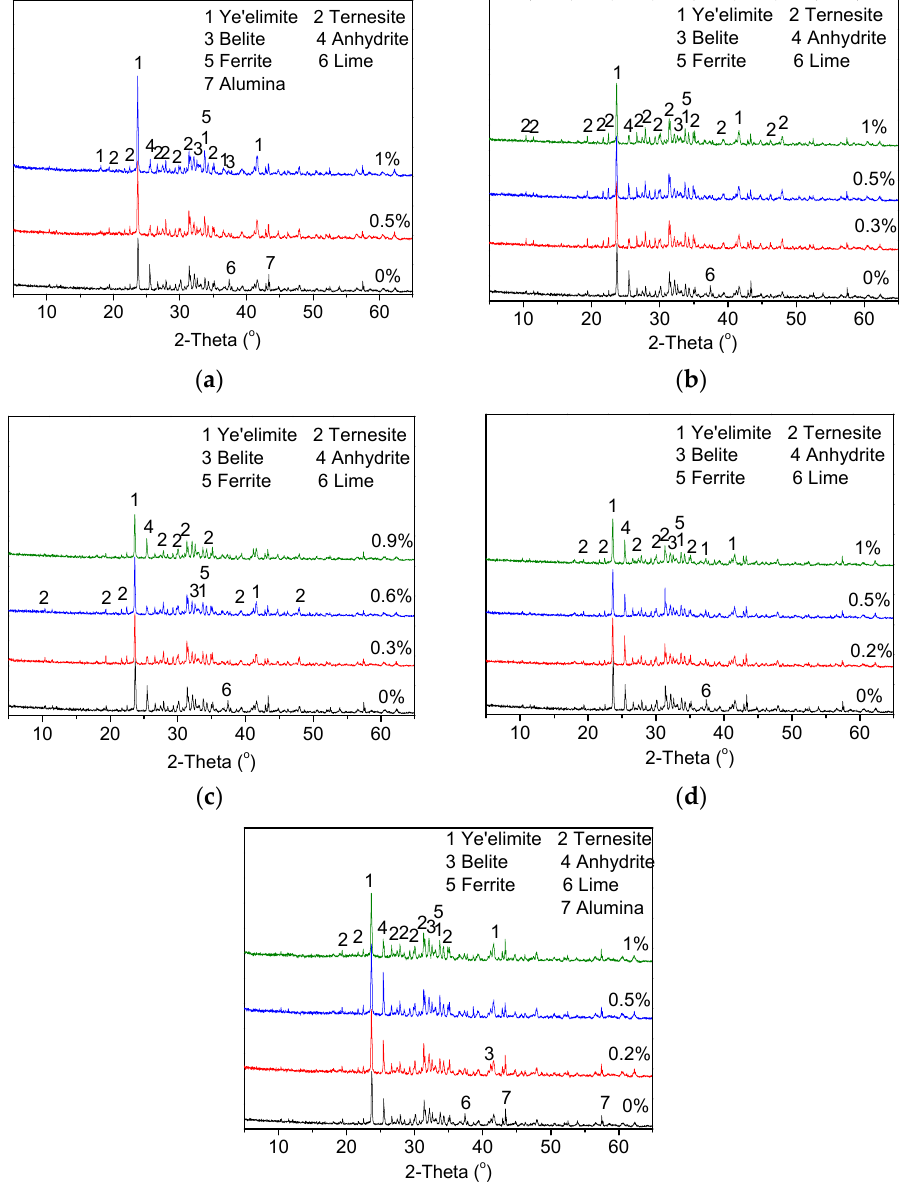
Figure 2. XRD patterns of doped cement clinker A. ( a ) CaF 2 ; ( b ) P 2 O 5 ; ( c ) Na 2 O; ( d ) MgO; ( e ) Fe 2 O 3. Table 5. Quantitative mineralogical compositions of doped cement clinker A (wt.%).